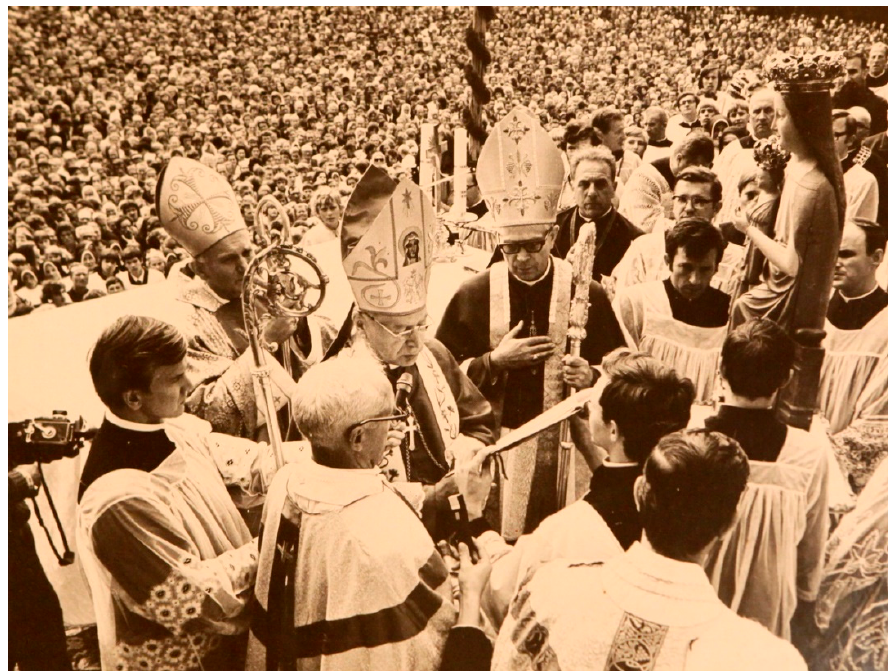
Figure 14. The Primate of Poland, Cardinal Stefan Wyszy ń ski, crowns the statue of Our Lady of Sejny in Sejny (6 September 1975) (photo: Archive of the Sanctuary of Our Lady of Sejny in Sejny).